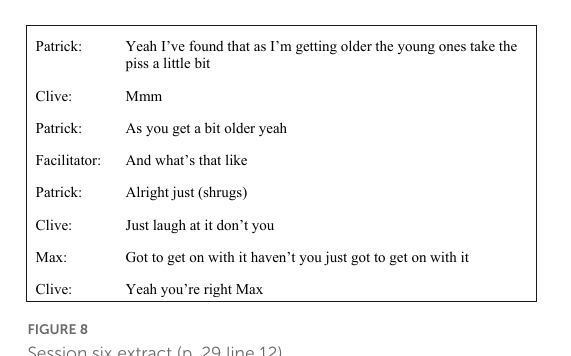
FIGURE8 Session six extract (p. 29 line 12).